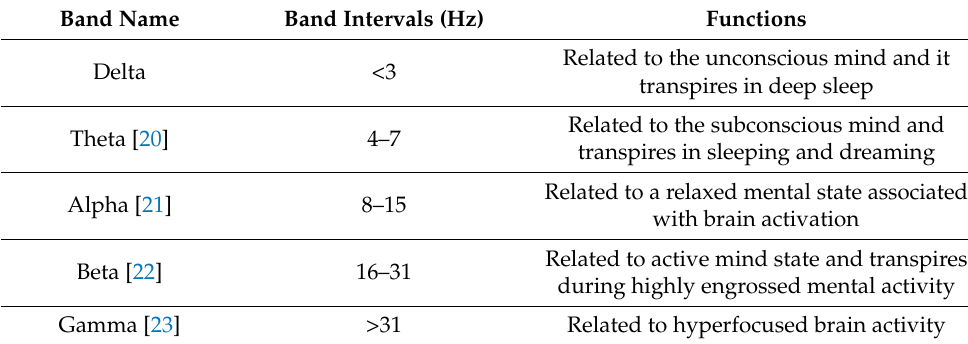
Table 1. EEG signals with their band